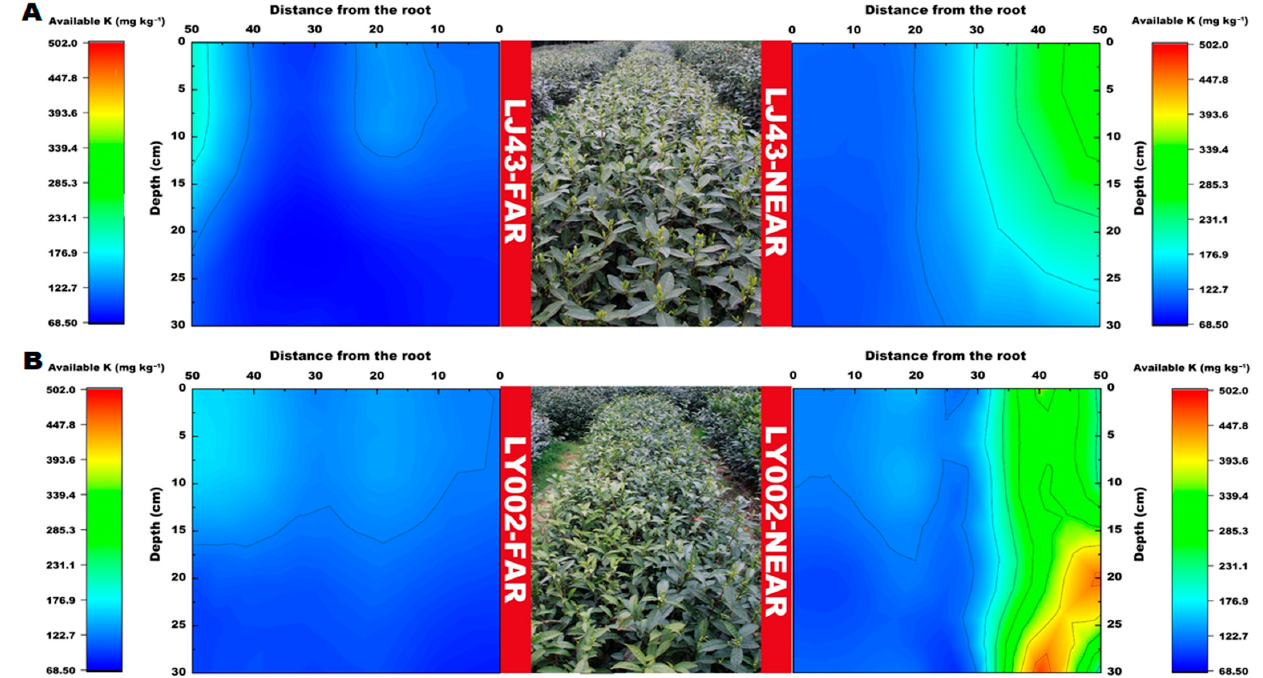
Figure 6. Variation in soil available K content related to LJ43 and LY002 with different treatments. ( A ): LJ43; ( B ): LY002. Data shows the mean ± standard deviation ( n = 3).